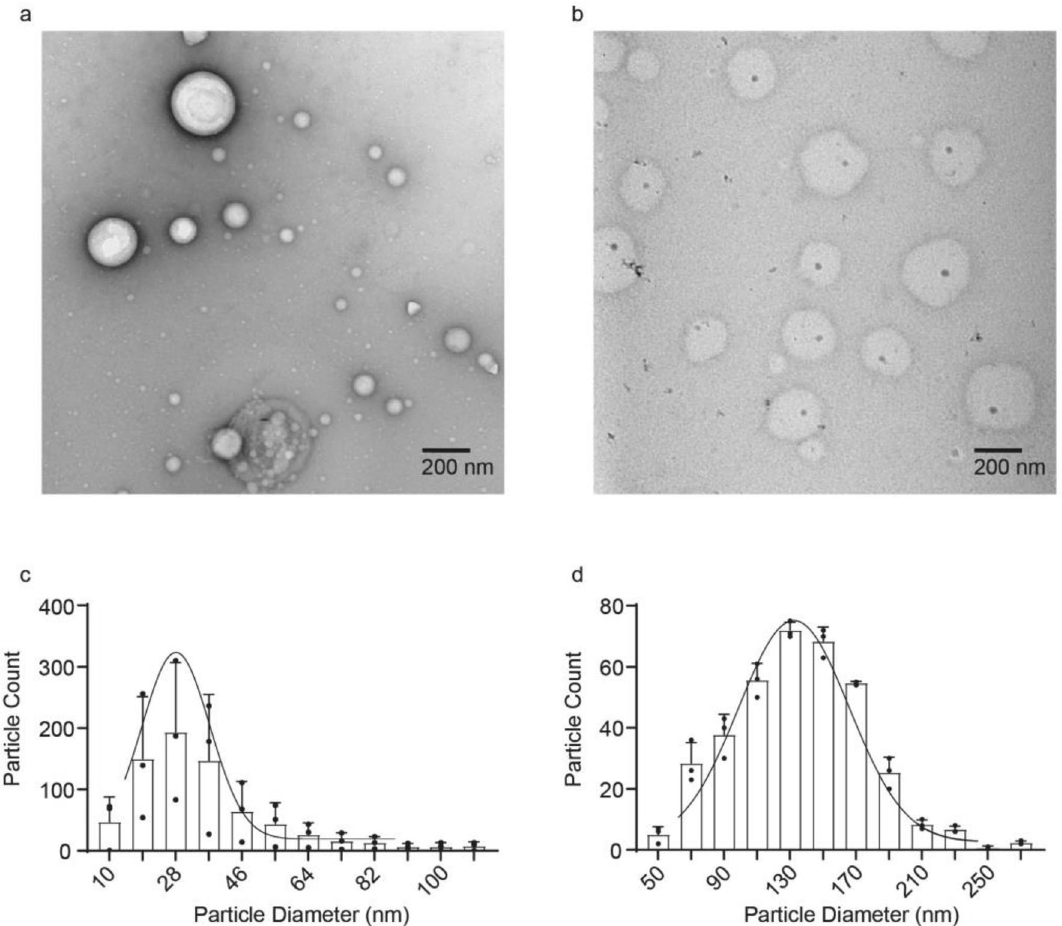
Figure 2. Lipid nanoparticle size is stabilized by mRNA. ( a ) Electron micrograph of liposomes without mRNA. ( b ) Electron micrograph of liposomes containing Luciferase mRNA. ( c ) Size distribution of the LNPs without mRNA. ( d ) Size distribution of the LNPs containing Luciferase mRNA. The Gaussian curve was drawn to ease the comparative visualization of the